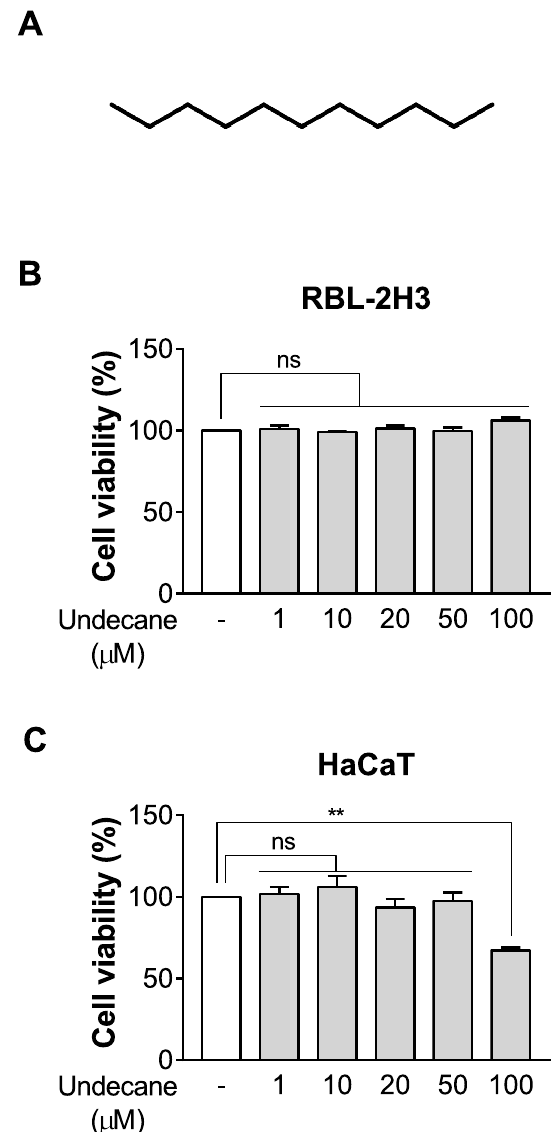
Figure 1. Effect of undecane on cell viability in RBL-2H3 cells and HaCaT cells. ( A ) The structure of undecane. ( B ) Cell viability was determined after incubation with vehicle (DMSO) or various concentrations of undecane (1, 10, 20, 50 and 100 μM) in RBL-2H3 cells and ( C ) HaCaT cells for 24 h. The data were expressed as the mean ± SEM ( n = 3). Significant differences between groups are indicated by asterisks; ns, not significant ( p > 0.05); ** p < 0.01.